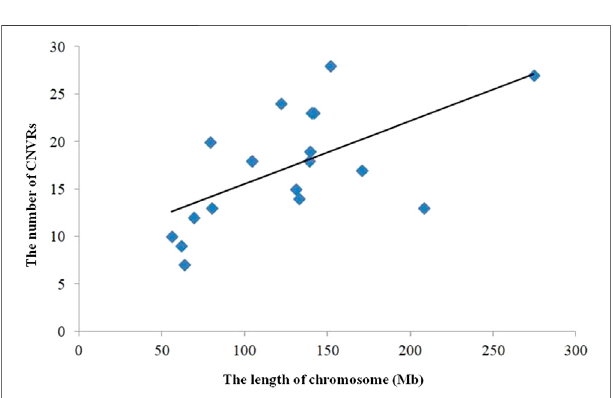
FIGURE 3 | Correlation CNVR numbers and chromosome